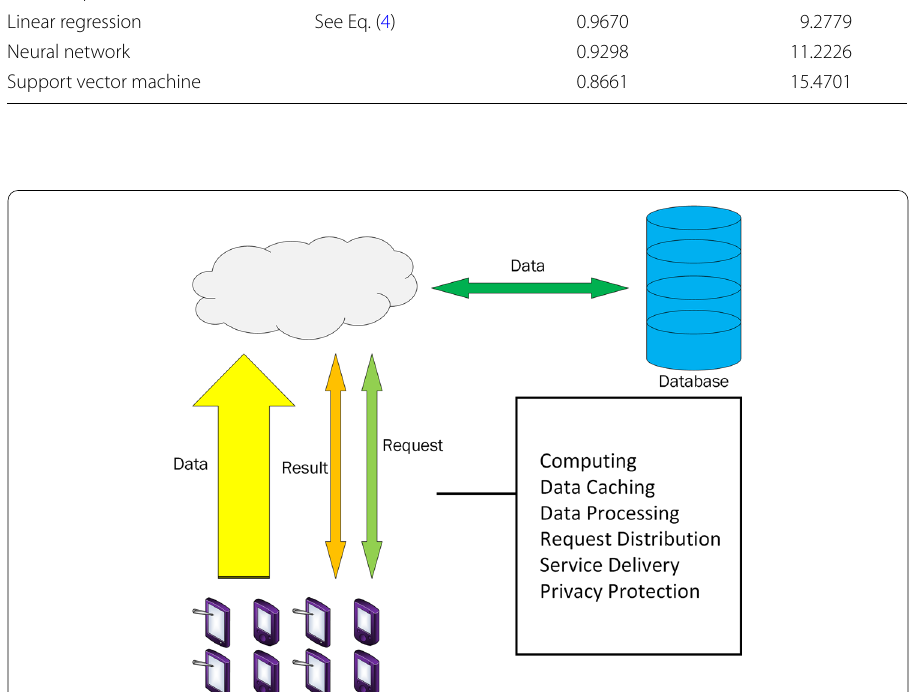
Fig. 5 Data transfer between nodes and